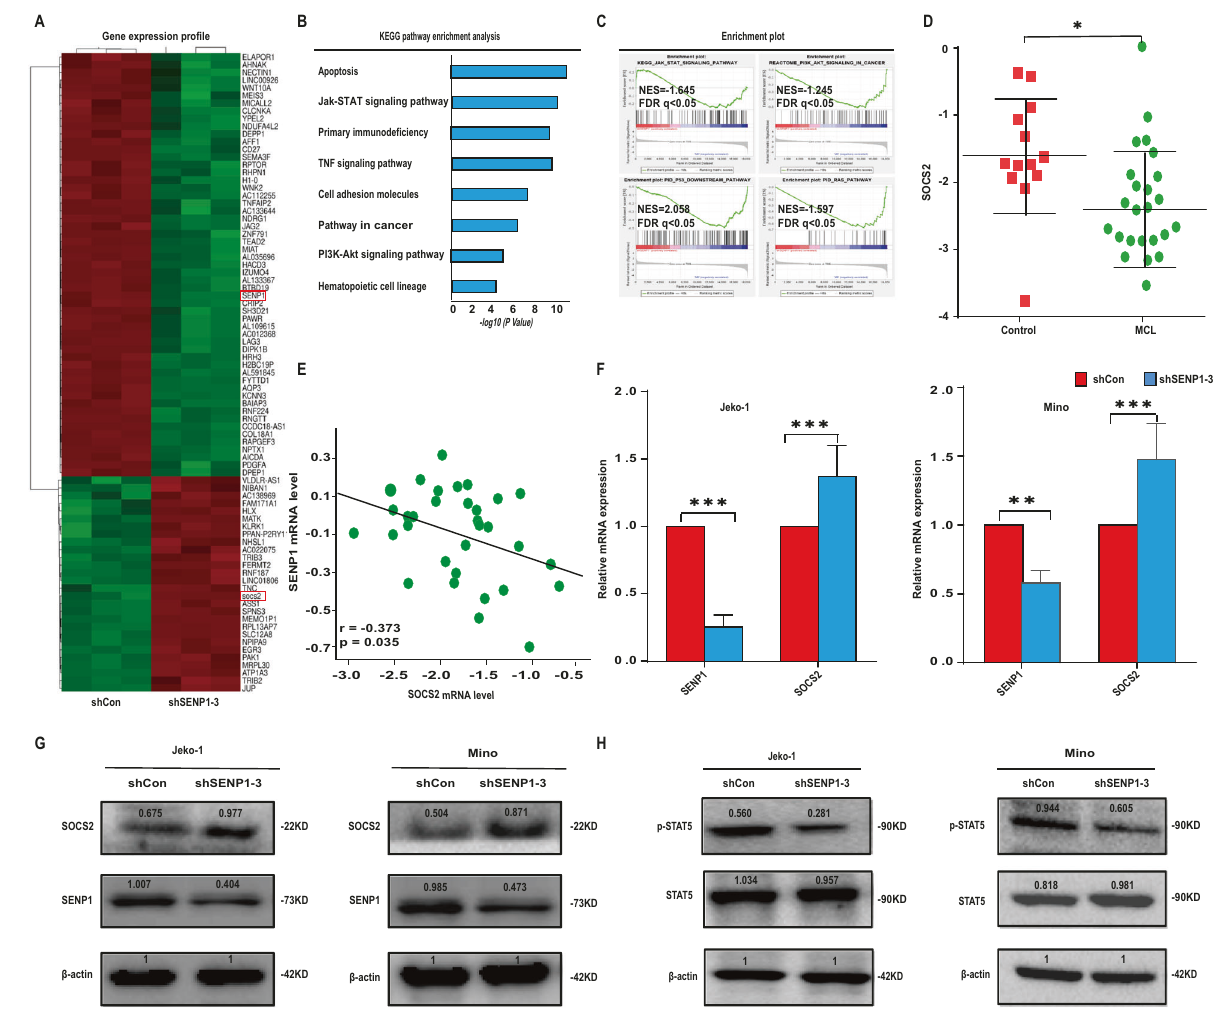
Fig. 4 SENP1 affects JAK-STAT5 signaling pathway in MCL. A Heatmap revealed differentially expressed genes between Jeko-1 cells transfected with shCon and shSENP1-3. B KEGG enrichment analysis showed that differentially expressed genes were enriched at different signaling pathways after SENP1 knockdown. C GSEA was performed using differentially expressed genes. D SOCS2 mRNA level in human MCL samples and normal control samples was analyzed through extracting GEO RNA-seq data. E Pearson correlation analysis between SENP1 mRNA level and SOCS2 mRNA level using GEO RNA-seq data. SOCS2 mRNA level was measured by RT-qPCR ( F ), SOCS2 ( G ) and p-STAT5 ( H ) protein levels were measured by western blot in transfected Jeko-1 and Mino cells. Data were presented as mean ± SD and analyzed by two- sided Student ’ s t test. n = 3; * P < 0.05, and *** P < 0.001.